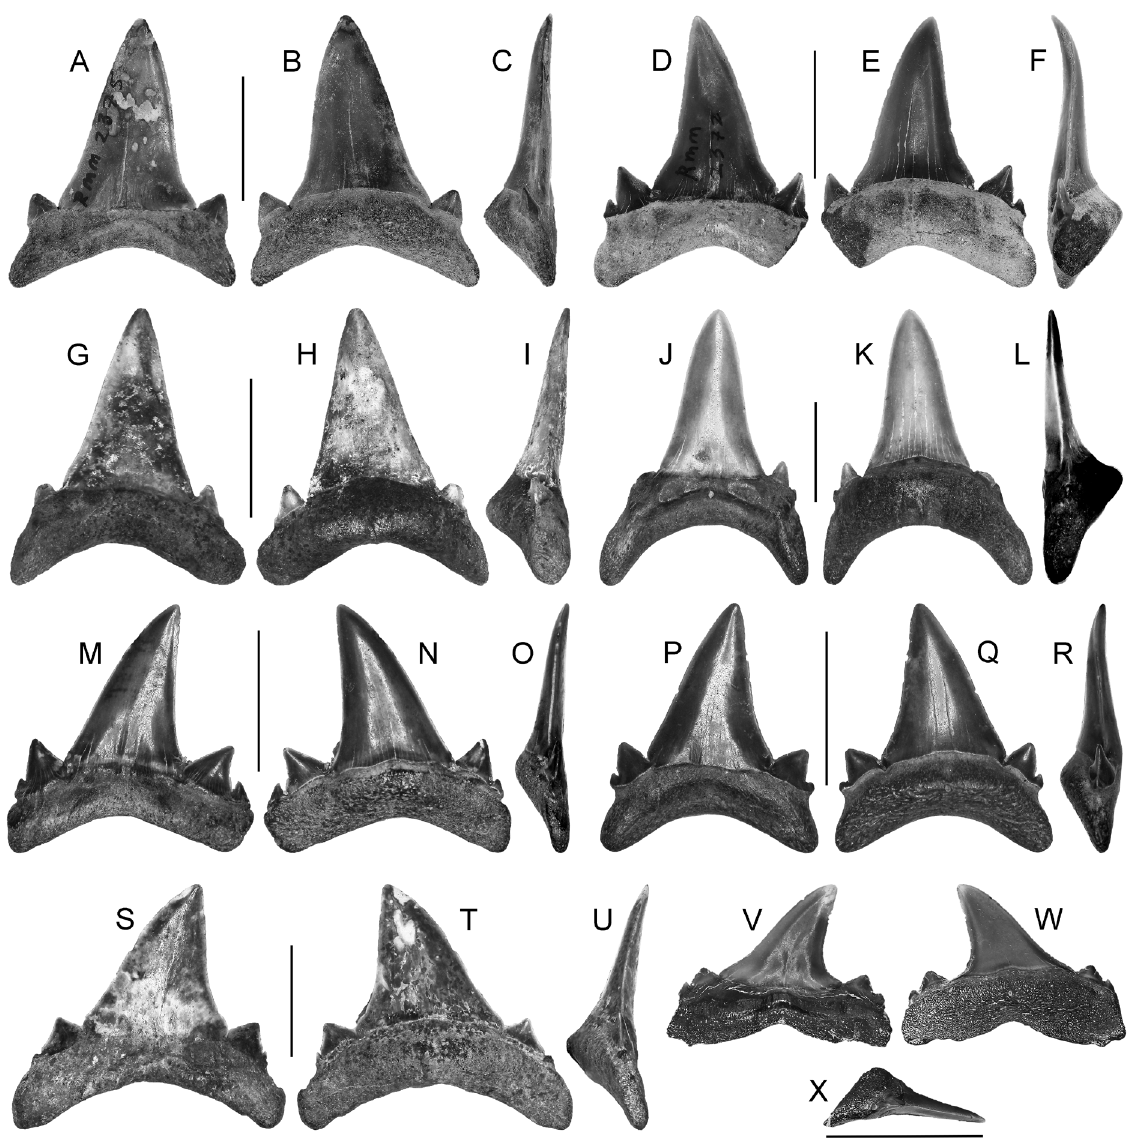
Fig. 14. Brachycarcharias twiggsensis (Case, 1981), teeth. A–C . MSC 2372.4, anterior tooth,